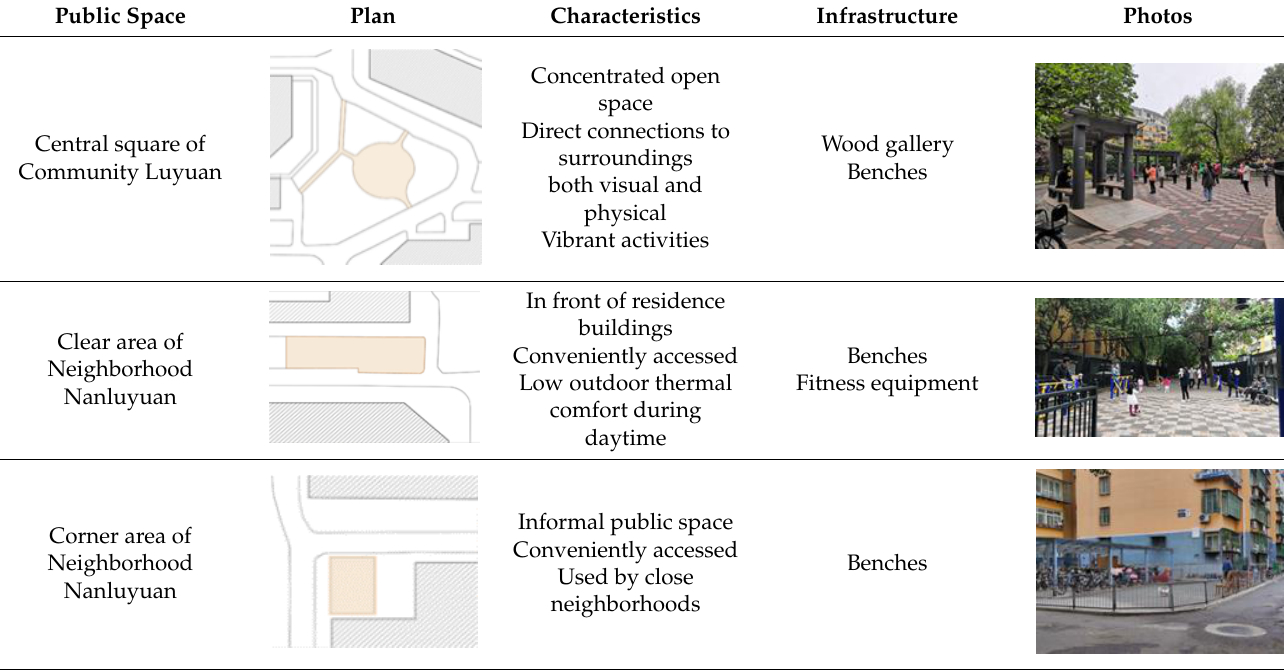
Table 3. Public space observation and mapping of Community Jianshebudayuan. Public Space